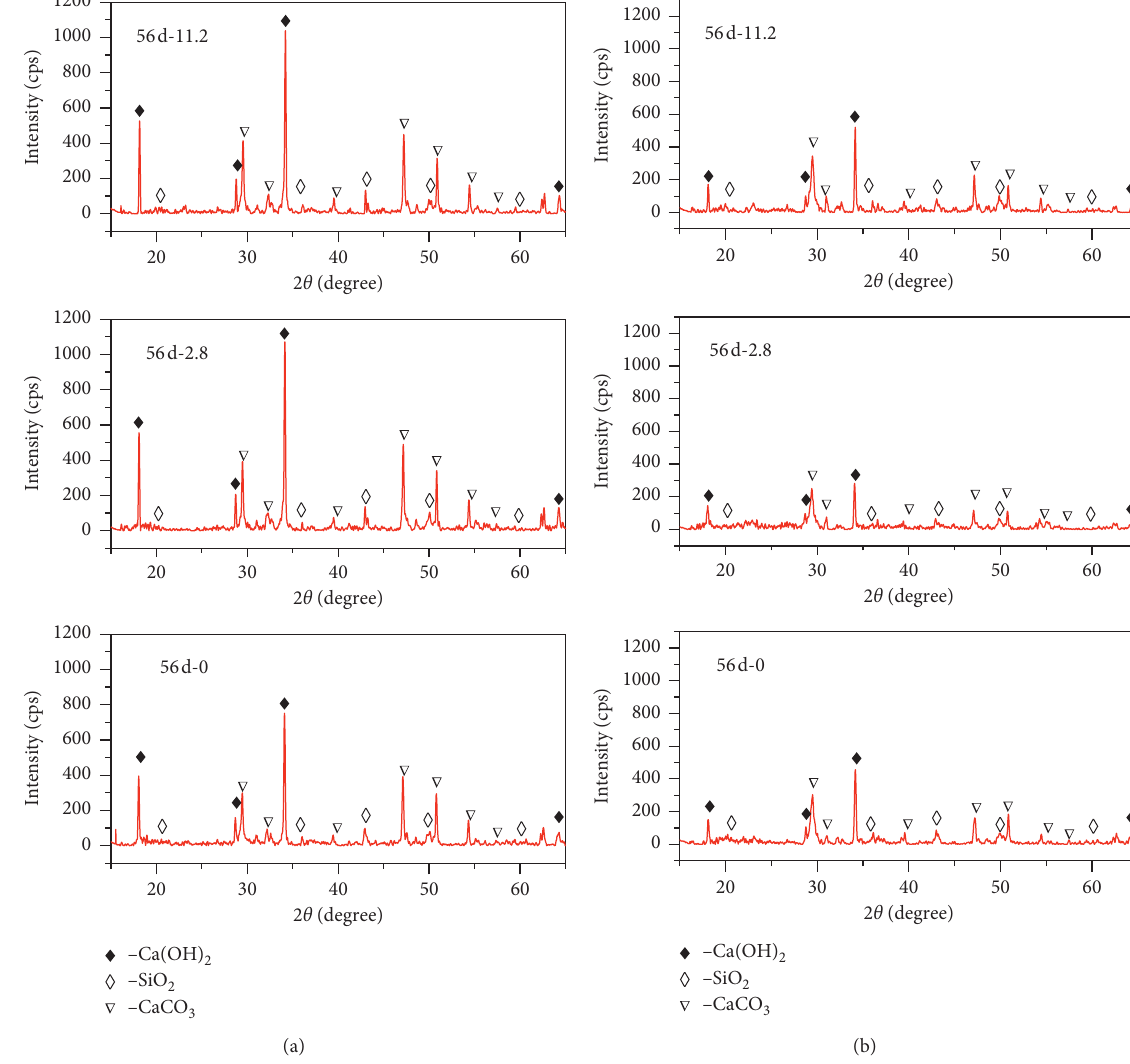
Figure 5: XRD of 56d leaching of specimens at different flow rates: (a) OPC; (b)